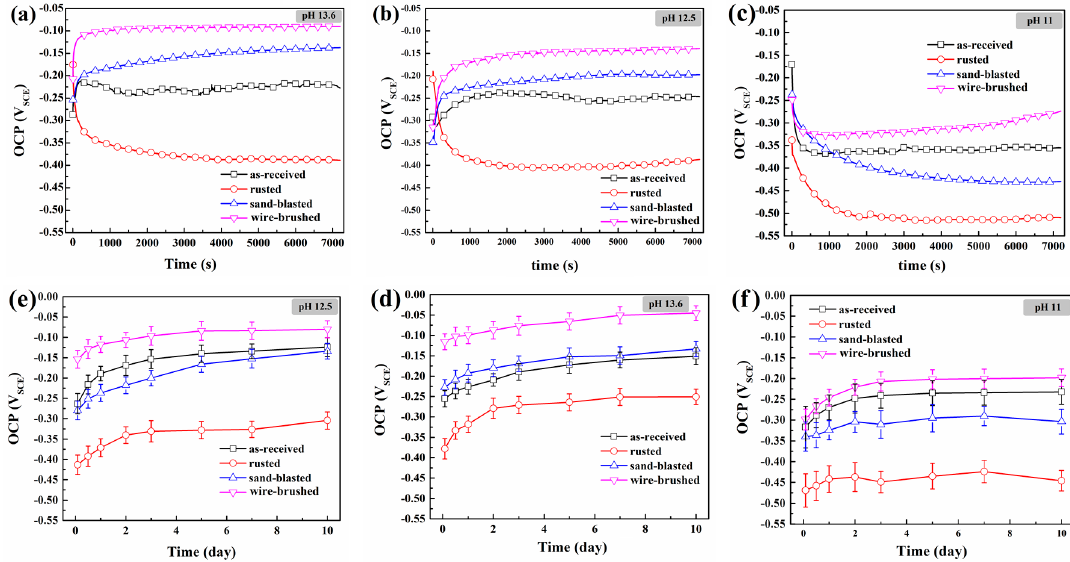
Figure 2. Open circuit potention (OCP) time variation curves of the steel rebar in the simulated concrete pore solutions of different alkalinity: ( a )–( c ) The curves obtained from the initial passivation for 2 h. ( d )–( f ) The curves obtained from the continuous immersion for 10 days.